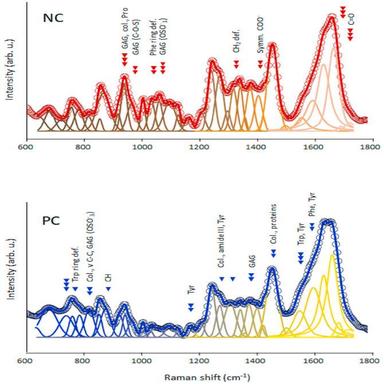
The average Raman spectra from nasal cartilage (NC) and perichondrial tissue (PC) were deconvoluted into their individual Raman peaks. Logistic regression analysis of the spectra to classify the tissue types identified the indicated peaks as characteristic of NC or PC tissue. The significance of the Raman peak for the model is shown with ◄◄◄: p < 0.001, ◄◄: p < 0.01, and ◄: p < 0.05. The Raman peaks were attributed to specific chemical compounds and substances.